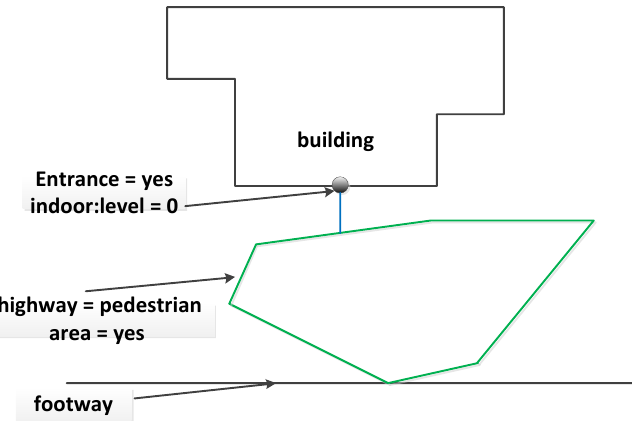
Figure 10. An example of using OSM closed ways to model the connection between indoor and outdoor environments. A way (in blue) and an area (in green) are created to link indoor and outdoor